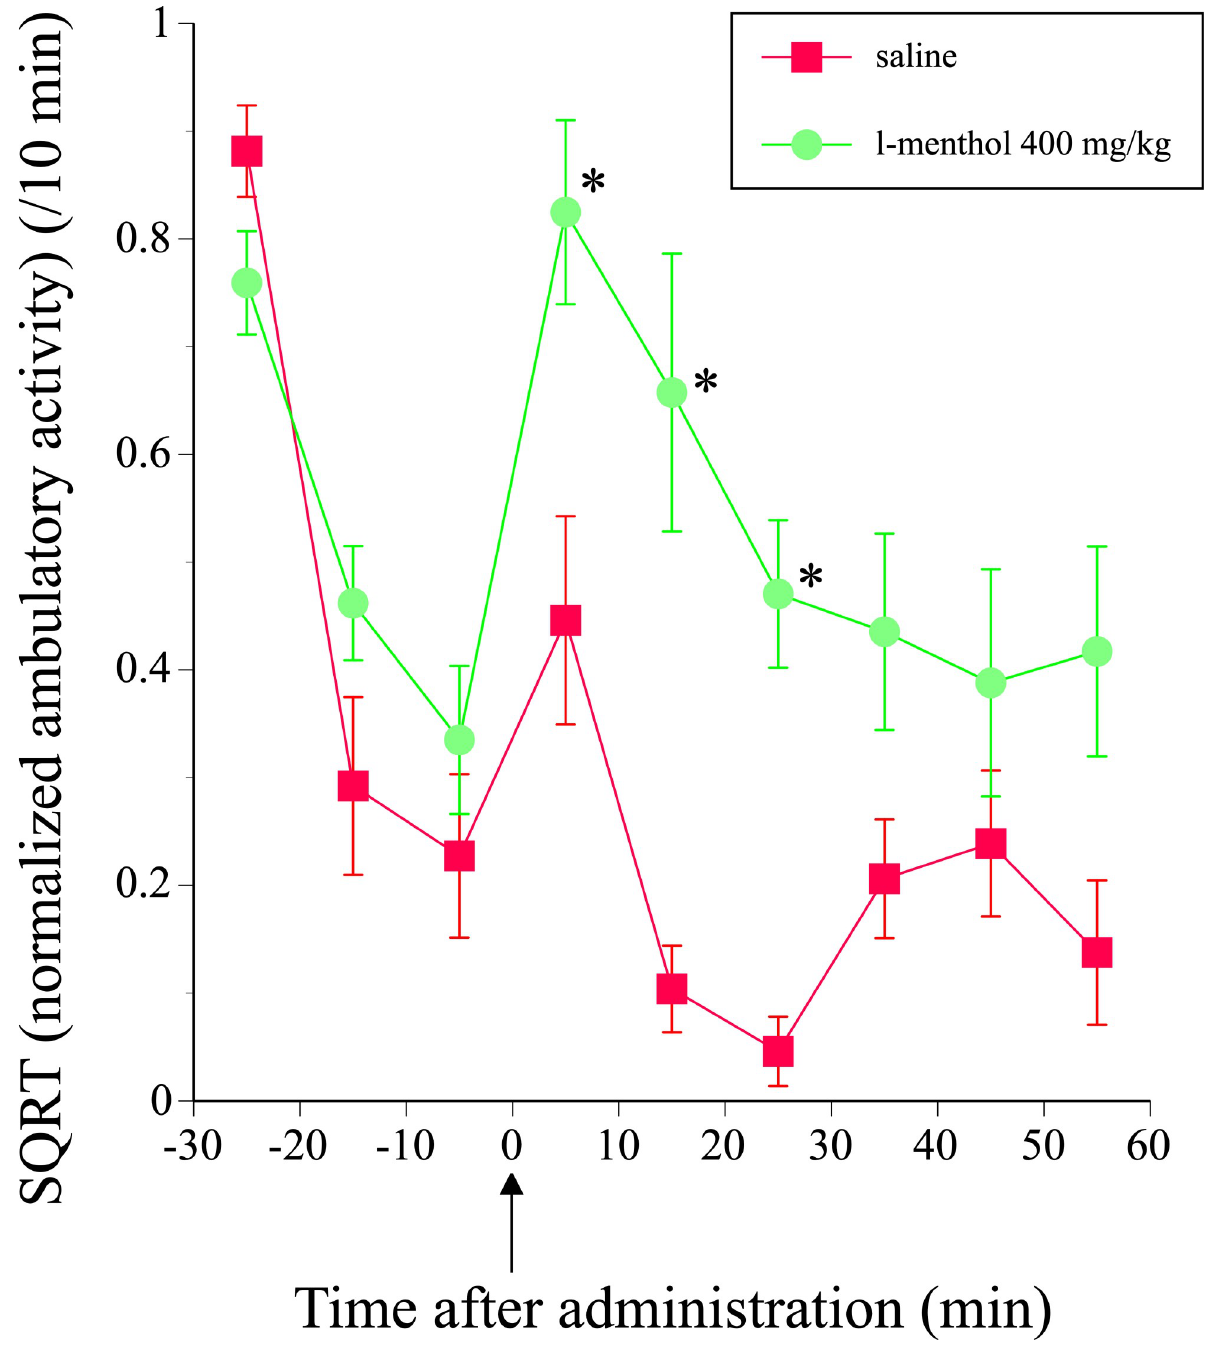
Fig 2. Time course of ambulatory activity before and after the subcutaneous administration of saline or 400 mg/kg l -menthol on the 4 th day (challenge session). All mice were administered saline and the ambulatory activity was measured on the 1 st to 3 rd days (acclimation sessions). On the 4 th day, 30 min after introduction into the activity cages, one group was administered saline (N = 7), the other group was administered 400 mg/kg l - menthol (N = 11), and the ambulatory activity was then measured for 60 min. The arrow indicates the time point of the administration. Immediately after the end of the ambulatory measurements, the mice were transcardially perfused with fixative, and their brains were collected for later use in c- Fos immunocytochemistry. Symbols show the mean values of the square-root- transformed ambulatory activity, that was normalized using the total ambulatory activity during the 30 min adaptation period before the administration, for each 10-min period that were plotted against the midpoint of the measurement period, and vertical lines denote the standard errors of the means. � P < 0.05 compared with the vehicle control by Tukey’s test. The data are presented in S1